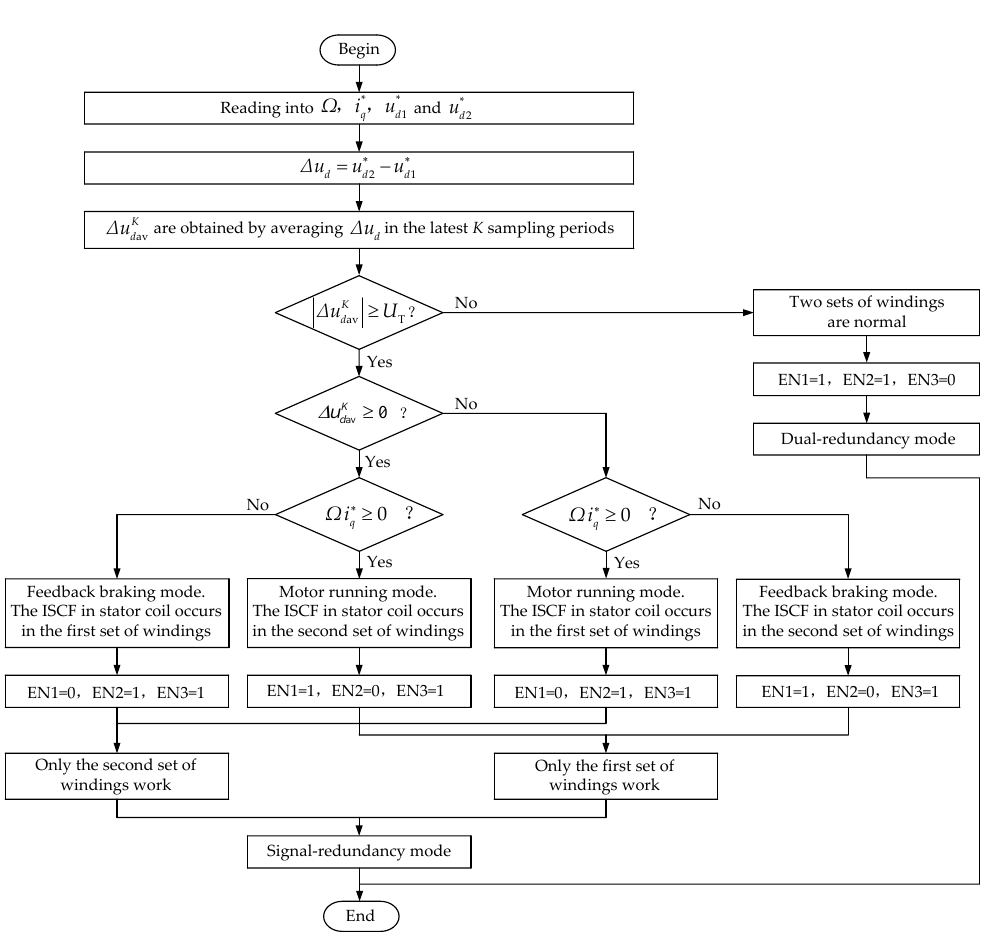
Figure 17. The logic block diagram of the fault diagnosis and redundancy controller.